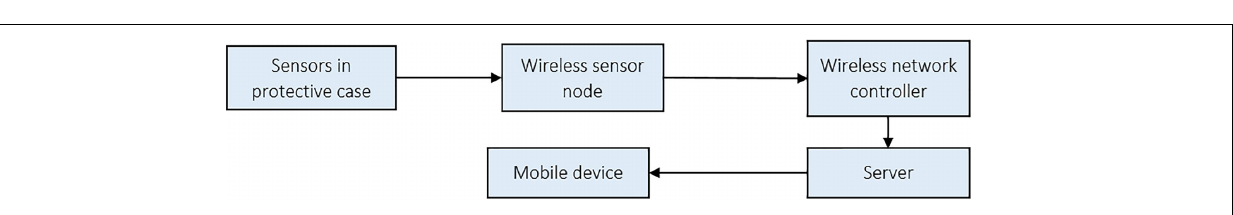
FIGURE 4 | Wireless system architecture for remote sensing of the protected cultivation